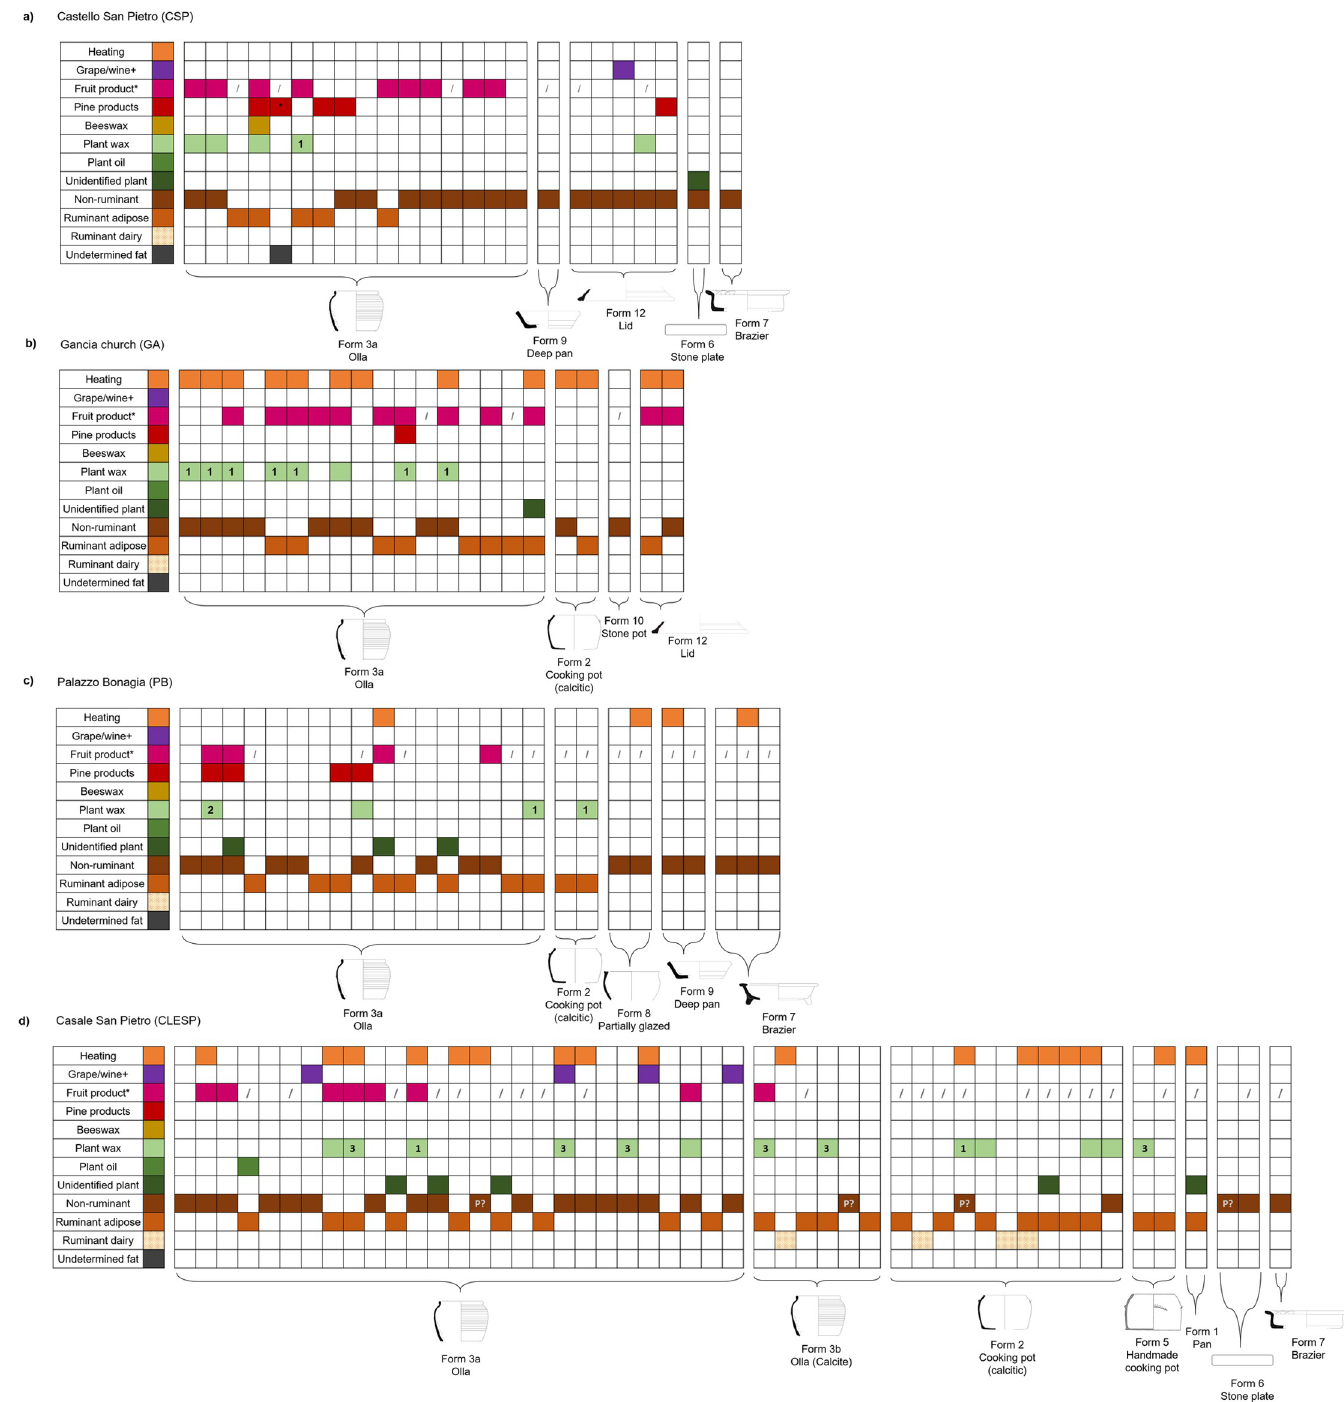
Fig 8. Summary figure of organic substances identified in pottery vessels from (a) CSP, (b) GA, (c) PB and (d) CLESP. Identification criteria of different commodities (ruminant dairy, ruminant adipose, non-ruminant, unidentified plant, plant oils, plant wax, beeswax, pine products, fruit products and grape products) are outlined in the text. Those not analysed for fruit acids are shown (/). Non-ruminant, ruminant and dairy were assigned based on Δ 13 C values. In one case both ruminant and dairy were identified based on clear dairy TAG distribution. Where P is noted in non-ruminant this refers to samples tentatively assigned to porcine. Specific taxonomy of plant waxes is indicated brassica (1), leek (2) and broadleaf sternum or fennel (3). In pine products pitch is indicated by ( � ). Evidence of heating was presumed in the presence of ketones C31, C33 and C35 [78] and/or APAAs [112, 113]. Vessel drawings used as examples based on actual vessels from CSP and PB [33, 34].